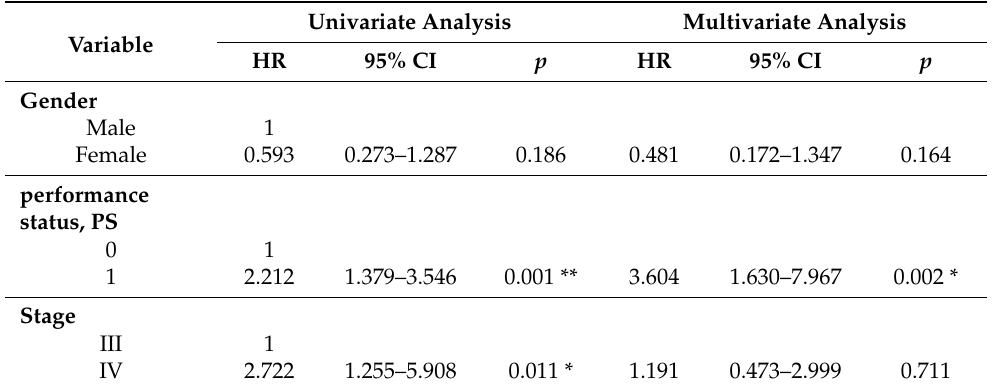
Table 2. Prognostic correlation factors (* p < 0.05, ** p < 0.001).